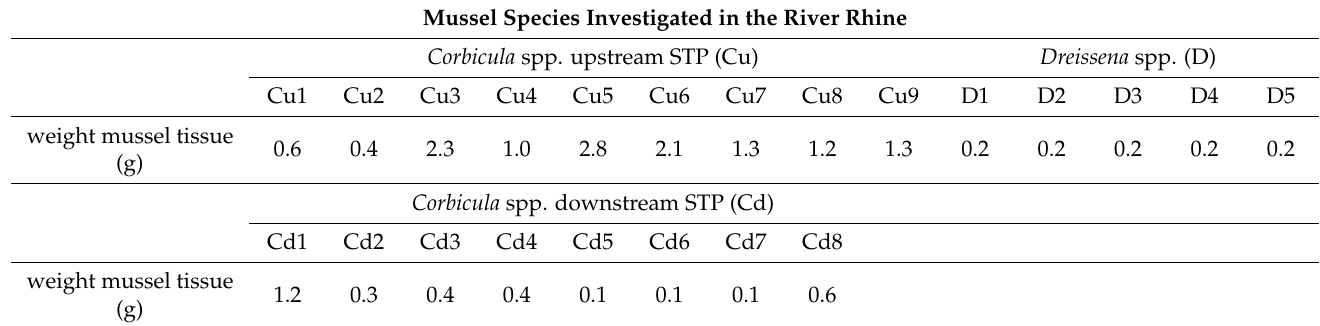
Table 1. Individual mussel soft tissue weight measured without shells and sampled at the three different sampling sites. Mussel Species Investigated in the River Rhine Corbicula spp. upstream STP (Cu) Dreissena spp. (D)